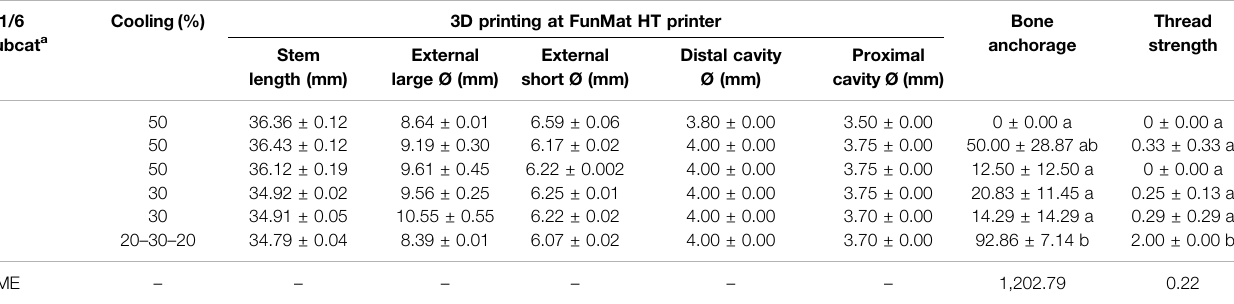
Equation 2 . Simple correlation of short Ø between SW (Short Ø SW ) and radii medullary cavity (Short Ø MC ) ( R 2 (cid:1) 0.99; r (cid:1) 0.99;